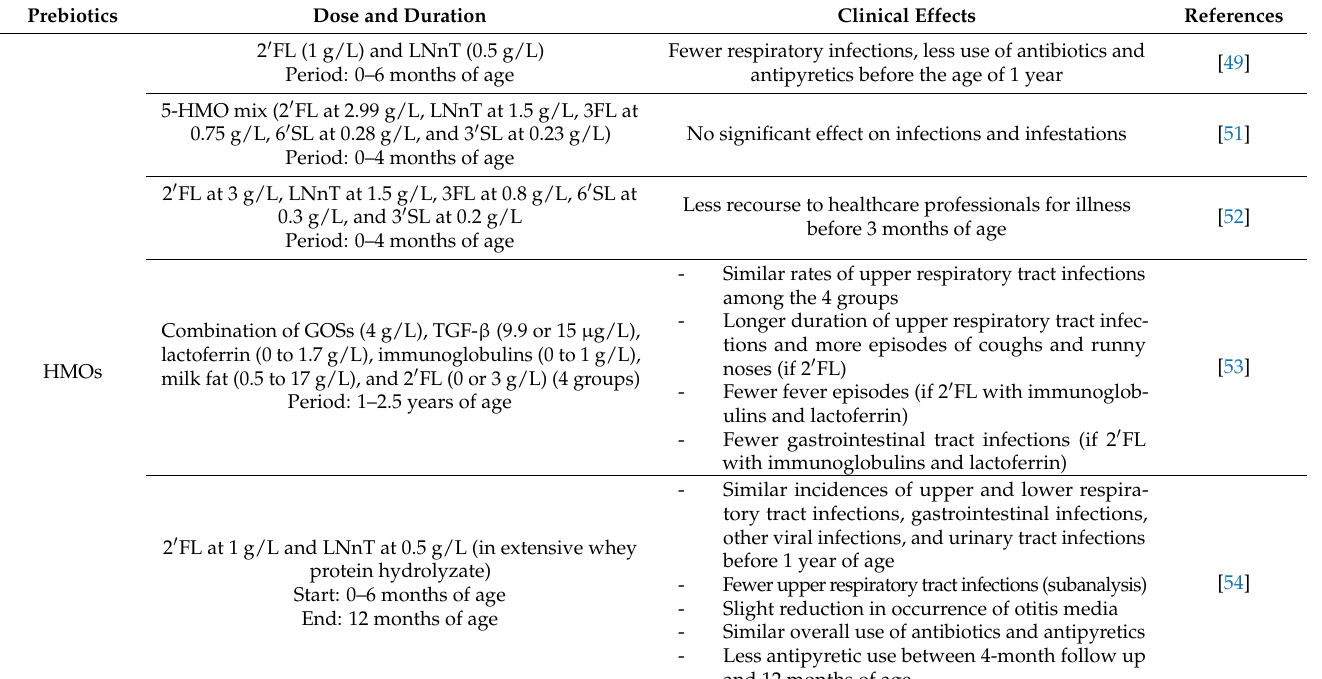
Table 2. Summary of clinical effects of prebiotics compared to control groups with non-supplemented infant